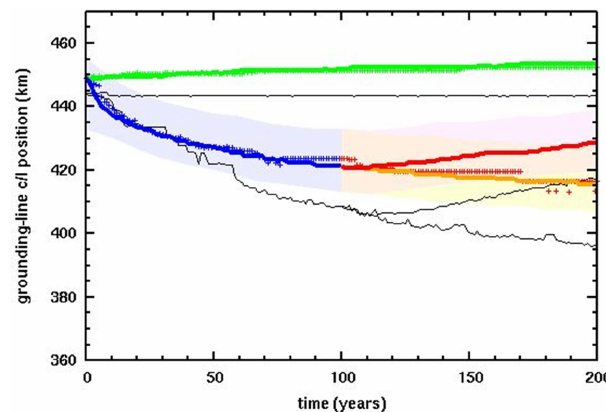
Figure 6. As Fig. 3 except for the MISMIP + Ice2 experiments. Shading for the “main subset” of MISMIP + models is copied from Cornford et al. (2020, their Fig.